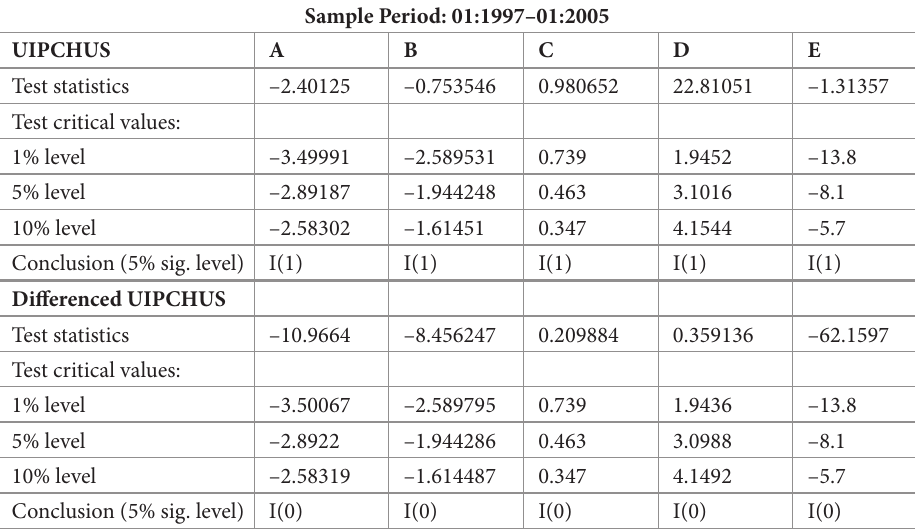
table 3. Alternative unit root tests for China interest rate &